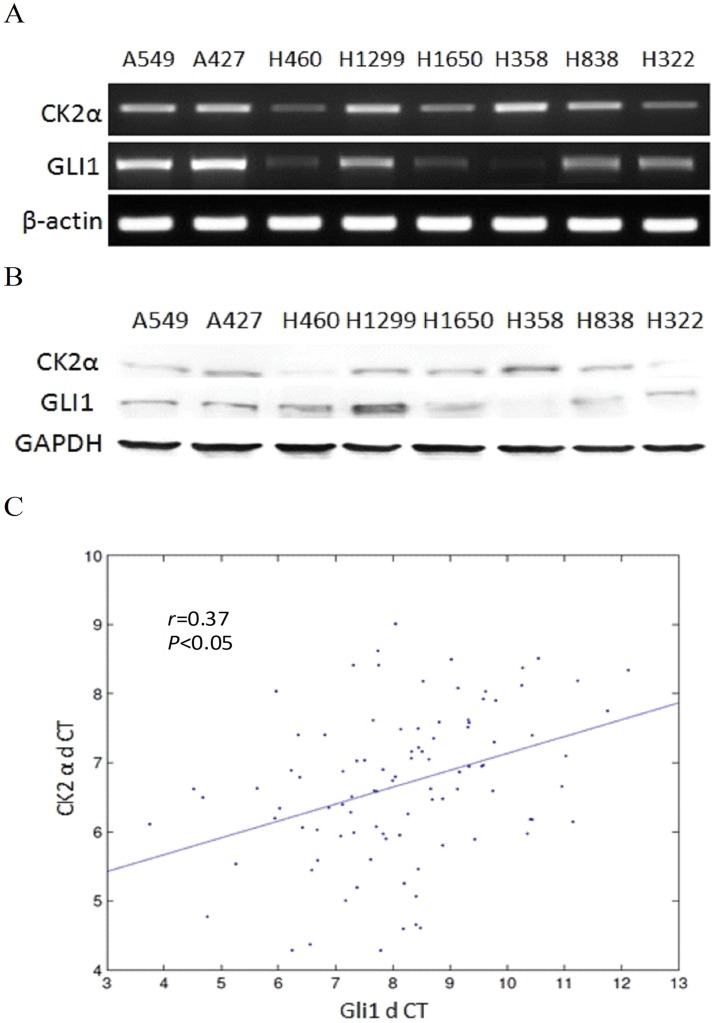
Over-Expression and Correlation of CK2α and Gli1 Genes in NSCLC.(A) RT-PCR. (B) Western blot. The CK2α gene was activated in the eight NSCLC cell lines examined (A549, A427, H460, H1299, H1650, H358, H838 and H322), and the Gli1 gene was expressed in all the cell lines except H358. (C) Linear correlation curve of CK2α and Gli1 mRNA levels. A mild correlation (r = 0.37, P<0.05) was shown in linear correlation analysis by SPSS. Primary NCSCL tissues from patients undergoing resection were collected at the time of surgery and immediately snap-frozen in liquid nitrogen. These tissue samples were kept at –170°C in a liquid nitrogen freezer before use.